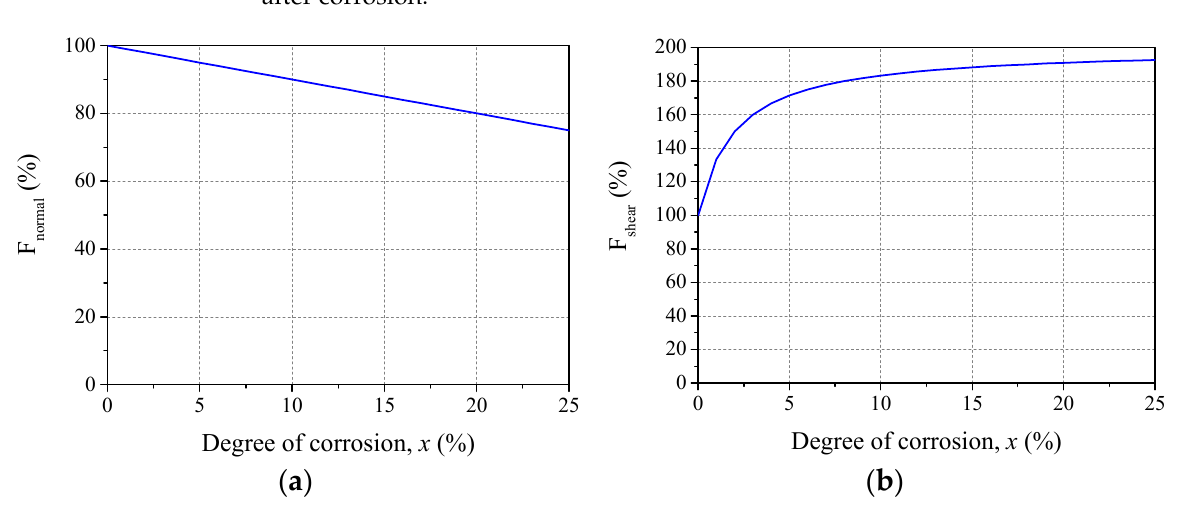
Figure 4. Variation of parameters according to degree of corrosion: ( a ) Modification factor for normal springs; and ( b ) modification factor for shear springs.